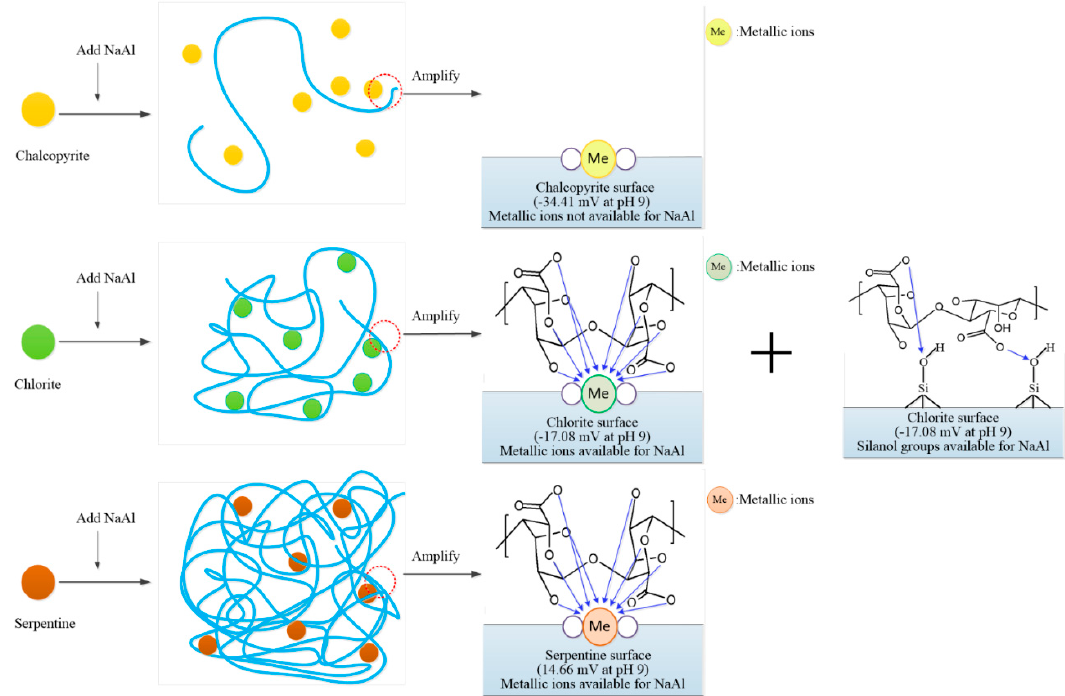
Figure 9. Schematic diagram of the adsorption behavior of NaAl on the minerals’ surface.